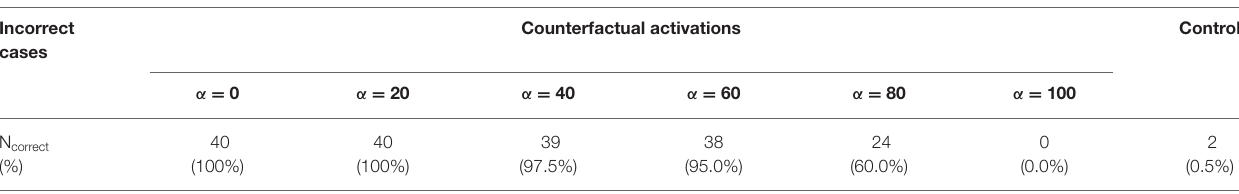
TABLE 3 | Decision of the DNN classifier on counterfactual activations obtained from misclassified brain activations. Incorrect